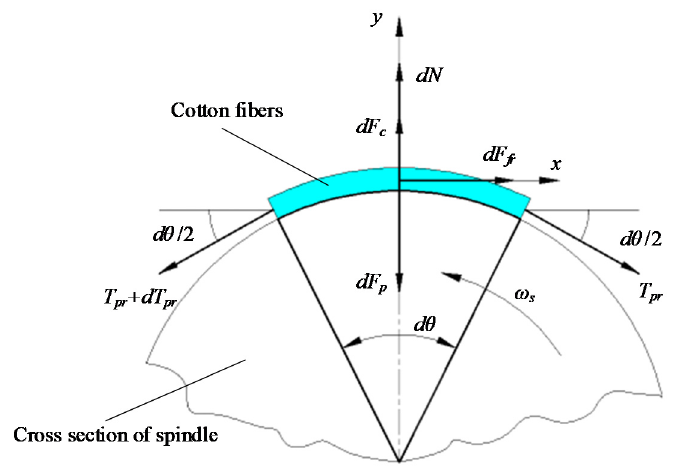
Figure 3. Free body diagram of the cotton sliver in the cross-section of the spindle.